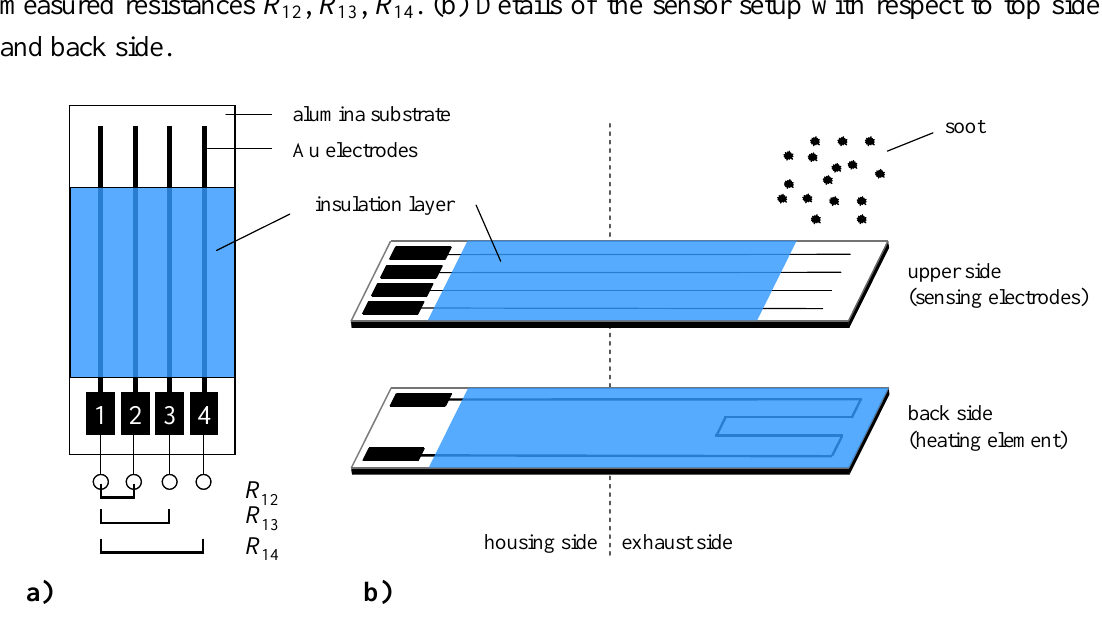
, R , R . (b) Details of the sensor setup with respect to top side 12 13 14